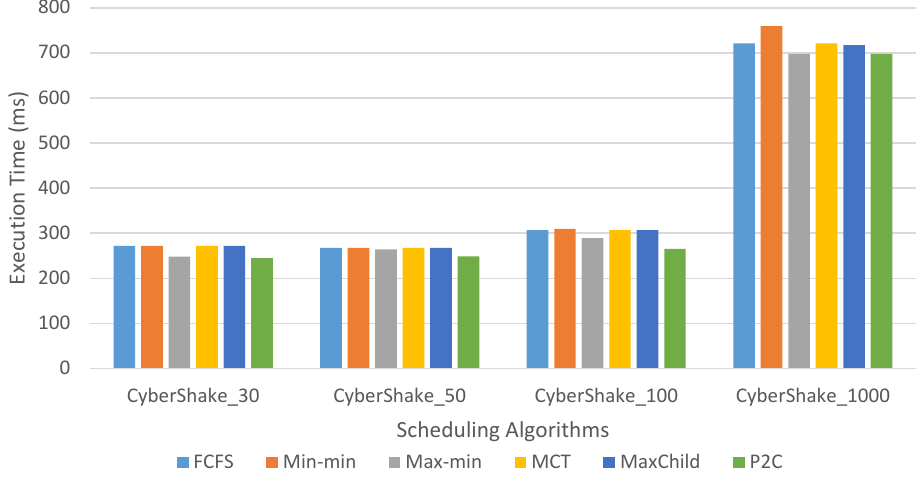
Figure 12. Comparison of execution time for CyberShake